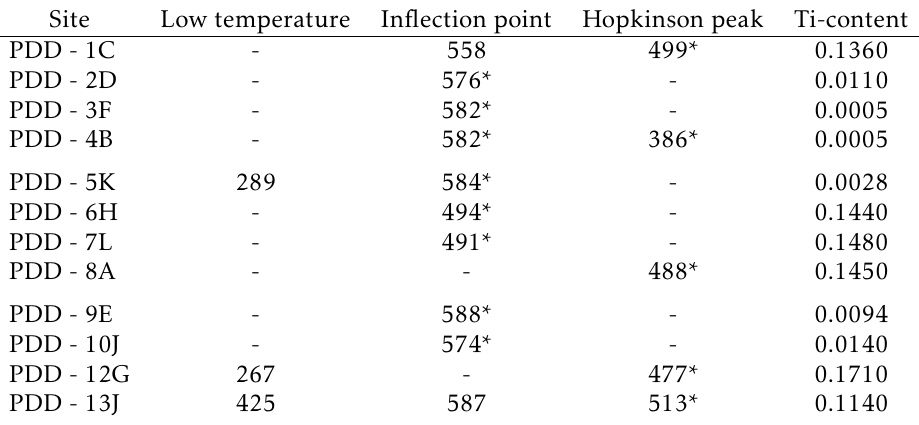
Table A2: Curie Point